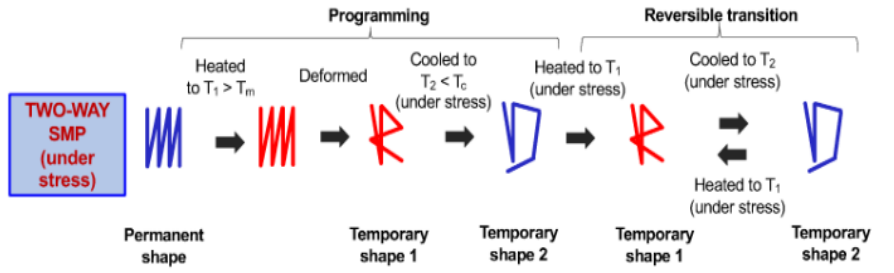
Figure 20. Diagram outline the programming and transition phases of a two-way shape memory polymer (Reprinted with permission from Scalet, G. [151]. Copyright 2020, CC BY 4.0 Interna- tional).